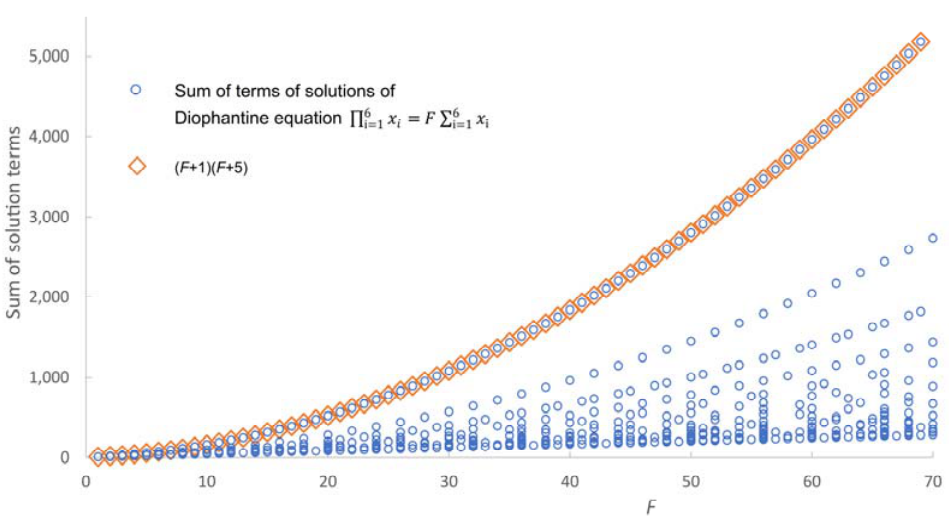
x i = F ∑ 6 x i with x i , F ∈ Z + are i = 1 i = 1